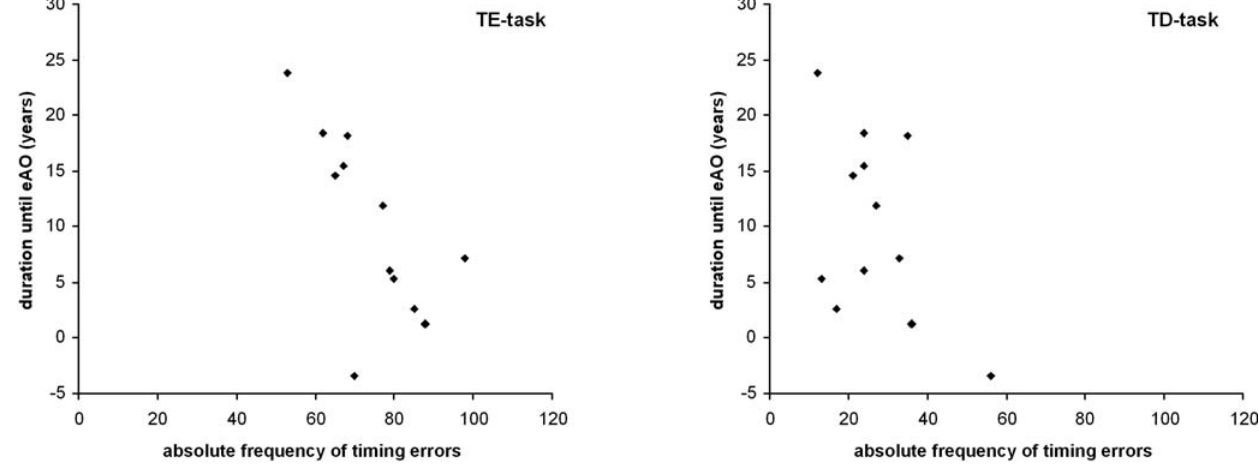
Figure 2. Relation of the performance in the TD and TE task to the duration until the estimated age of onset.